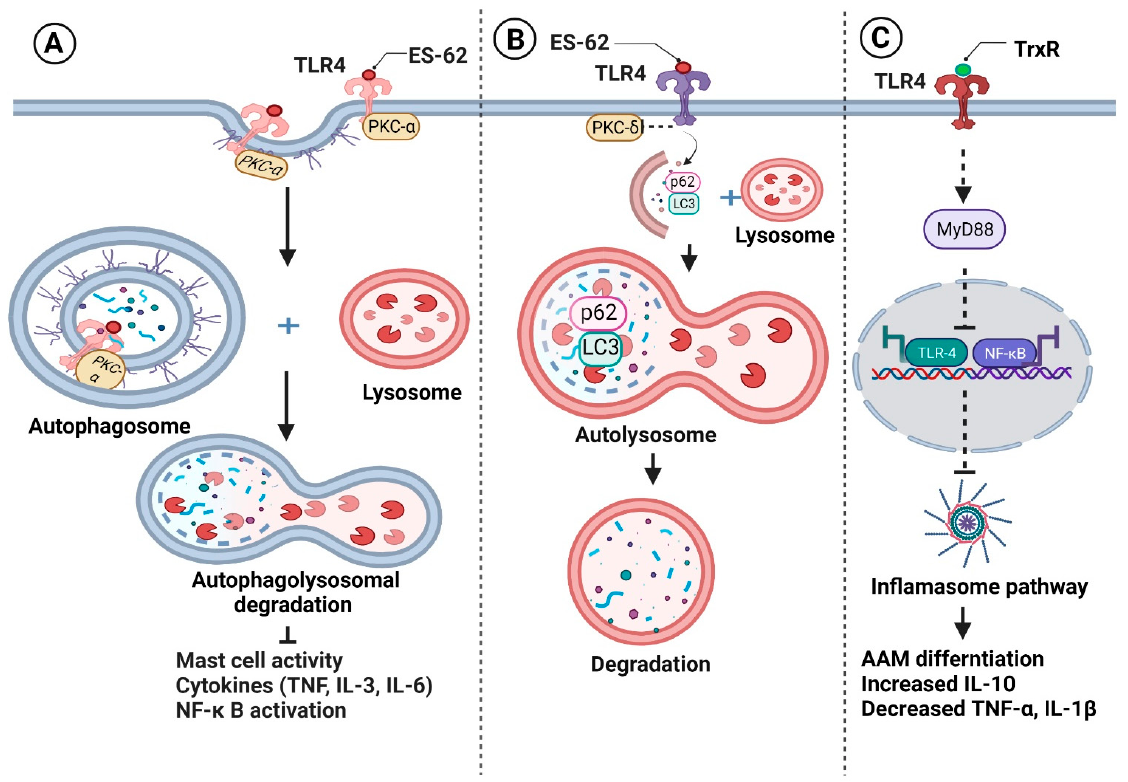
Figure 1. Filariae regulate pattern recognition receptors signaling for their survival. Filarial glyco- proteins such as ES-62 ( A ) form complexes with Toll-like receptor 4 (TLR) on monocytes, followed by their internalization and sequestration with protein kinase C- α and ( B ) down-regulate TLR4- associated protein kinase C- δ (PKC- δ ) in dendritic cells, followed by sequestration of p62 and LC3. As a result, sequestered components are degraded by autophagolysosomes, inhibiting the production of pro-inflammatory cytokines and inflammatory cell polarization. ( C ) Thioredoxin reductase (TrxR) inhibits the TLR4/NF- κ B pathway, prevents inflammasome activation, and induces alternatively activated macrophages (AAM) activation, which is characterized by an increase in anti-inflammatory IL-10 synthesis and a decrease in pro-inflammatory cytokines. Figure created using